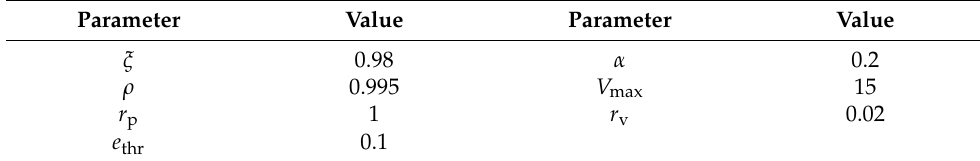
Table 2. Values of hyperparameters used in RL.